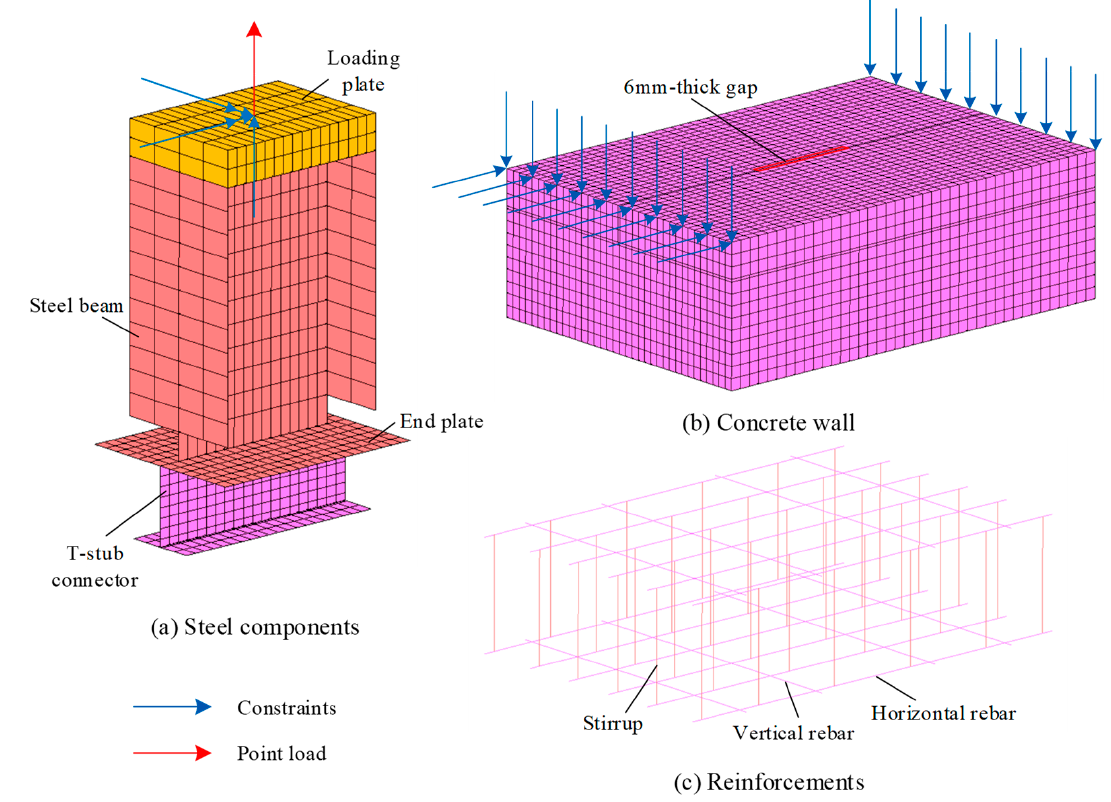
Figure 5. Numerical model of SBCW joints.